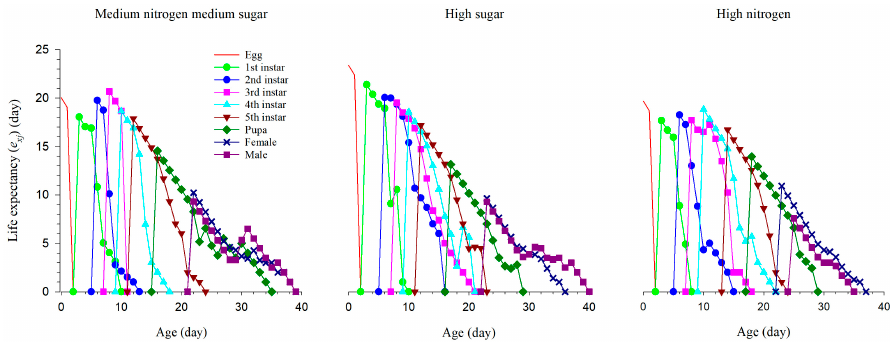
Figure 3. The age-special life expectancy ( e xj ) of S. exigua under three nutritional conditions.